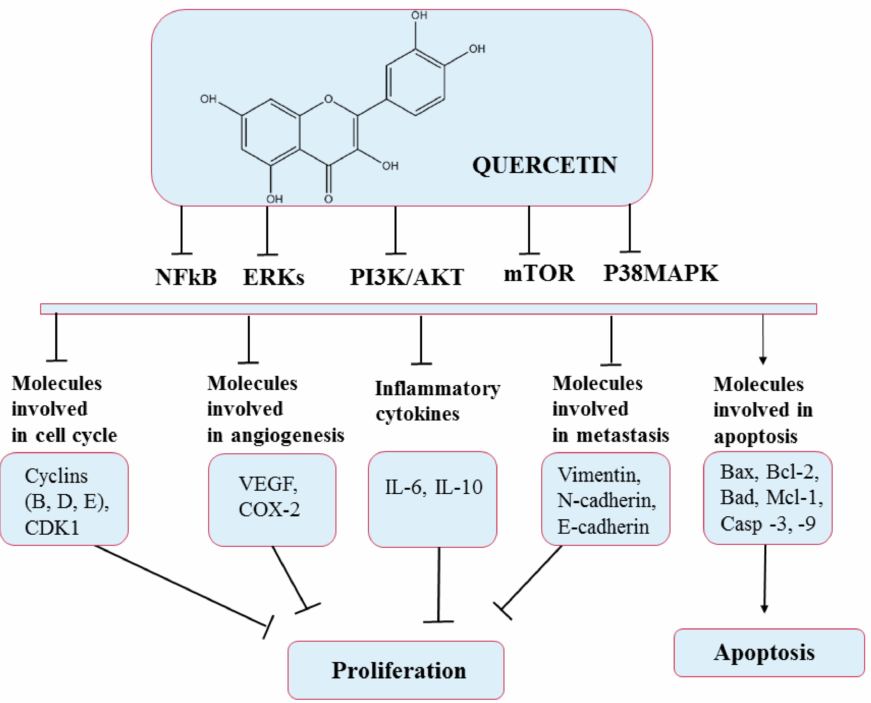
Figure 5. Chemical structure of quercetin and mechanism of action of quercetin through different molecular targets resulting in apoptosis or stopping